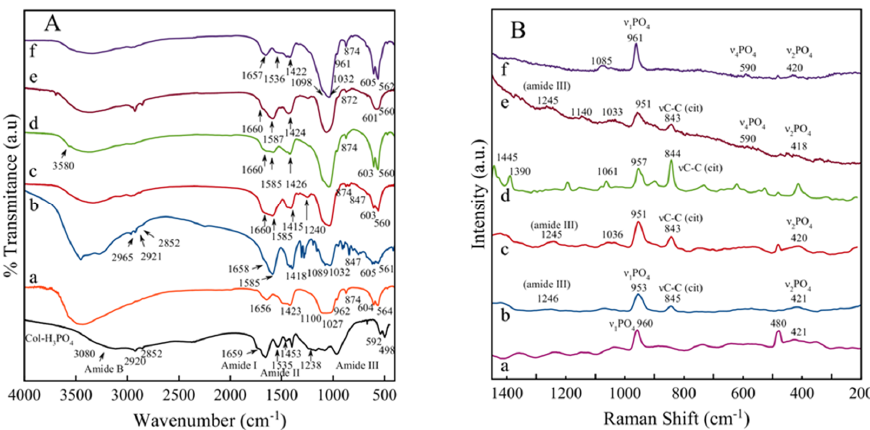
Figure 3. A ) FTIR spectra of mineralized type I collagen fibrils: a) Col/Ap, b) cit high –Col/Ap, c) cit low –Col/Ap,